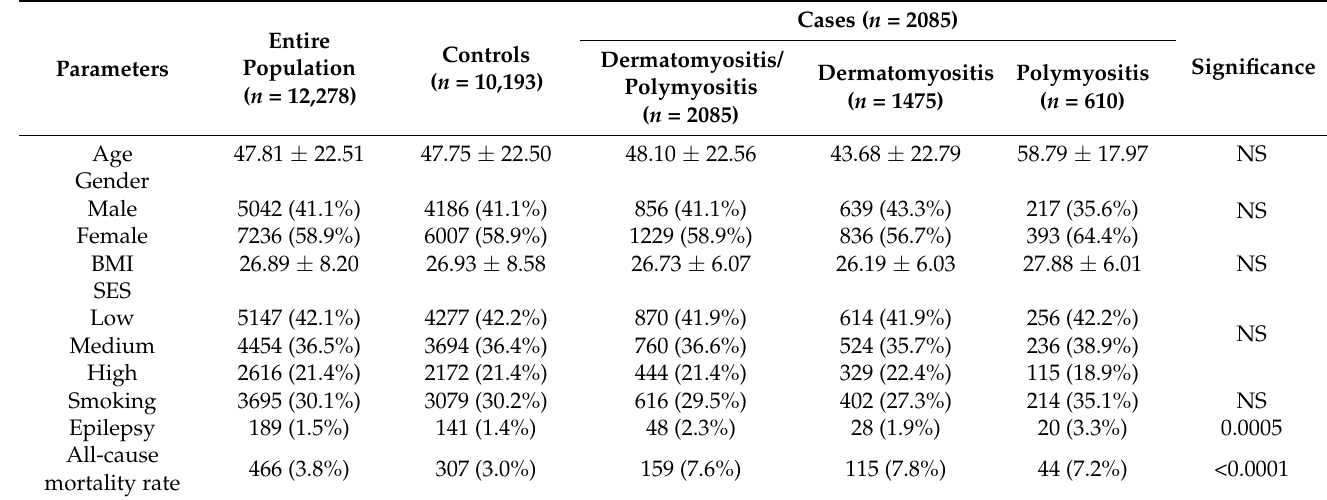
Table 1. Main population characteristics recruited in the present study.